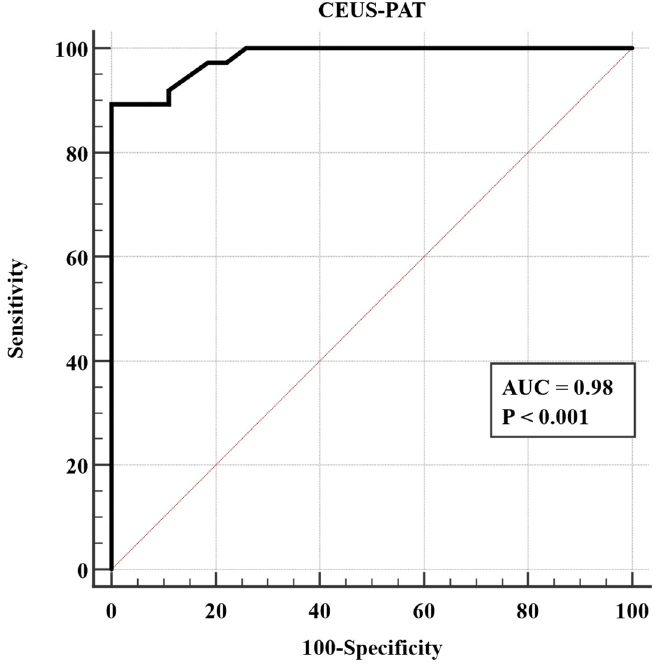
Figure 6. ROC analysis of CEUS-PAT in diagnosing liver cirrhosis.